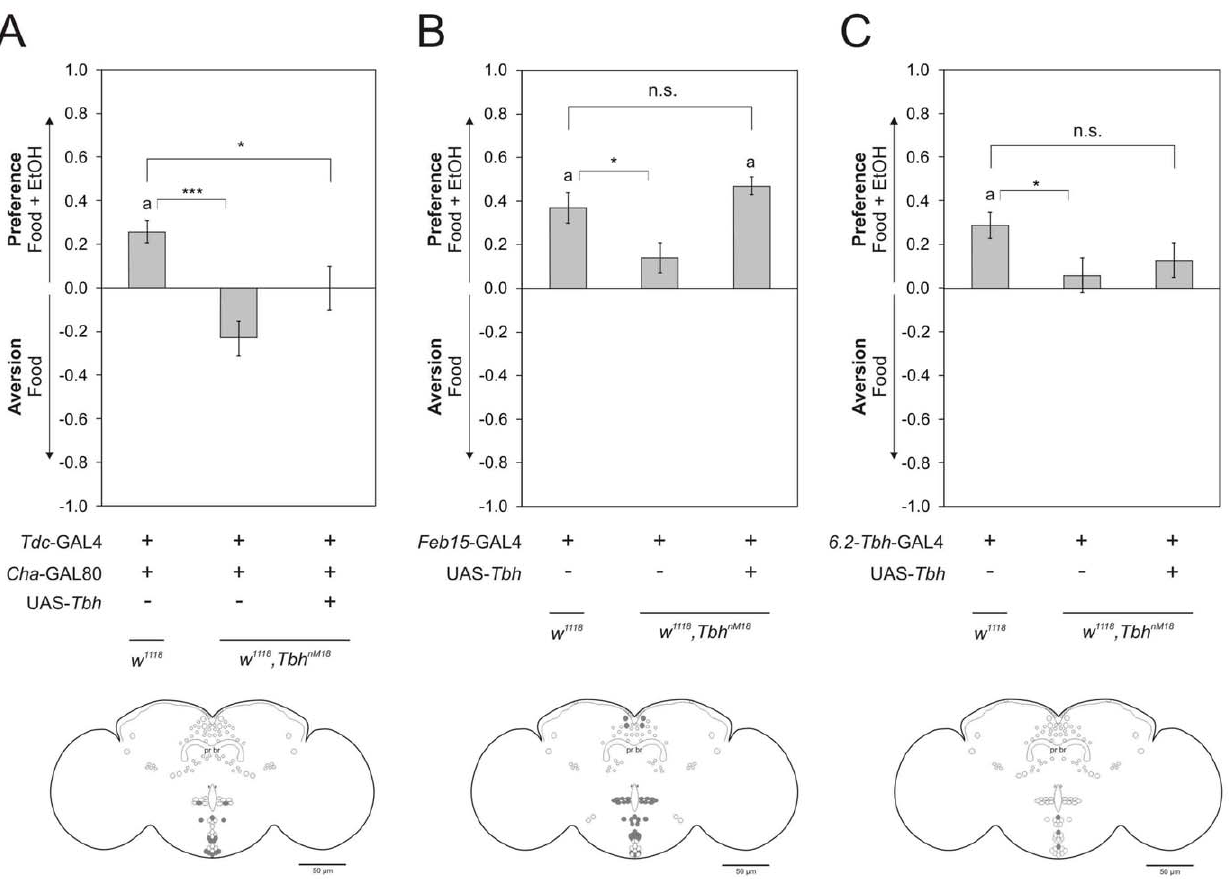
Figure 4. TbH is required in a subset of octopamingergic neurons for ethanol preference. a Expression of TbH in a Tdc2 -GAL4; Cha -GAL80 dependent manner in Tbh nM18 mutants does not restore preference (PIs are Tdc2 -GAL4/ + ; Cha -GAL80/ + : 0.26 6 0.05, Tbh nM18 ; Tdc2 -GAL4; Cha -GAL80/ + 0.23 6 0.08 and Tbh nM18 , UAS-Tbh ; Tdc2 -GAL4; Cha -GAL80/ + 0.00 6 0.10, n 27, 22 and 25. The experimental group does not develop preference and differs significantly from the control. The transgene insertion in the mutant background differs significantly from respective control. P , 0.05 and , 0.001.). b Feb15 -GAL4 dependent expression of TbH in Tbh nM18 mutants restores preference (PIs are w 1118 ; Feb15 -GAL4/ + 0.37 6 0.07; w 1118 , Tbh nM18 ; Feb15 -GAL4/ + 0.14 6 0.07 and w 1118 , Tbh nM18 , UAS-Tbh ; Feb15 -GAL4/ + 0,47 6 0.04. n 28, 33 and 36. The level of preference of the experimental group does not differ from the control. The transgene insertion in the mutant background differs significantly from respective control. P , 0.05.). c Loss of preference in Tbh nM18 mutants is not completely restored by TbH expression under the control of the 6.2-T bh -GAL4 driver (PIs are w 1118 ; 6.2-Tbh